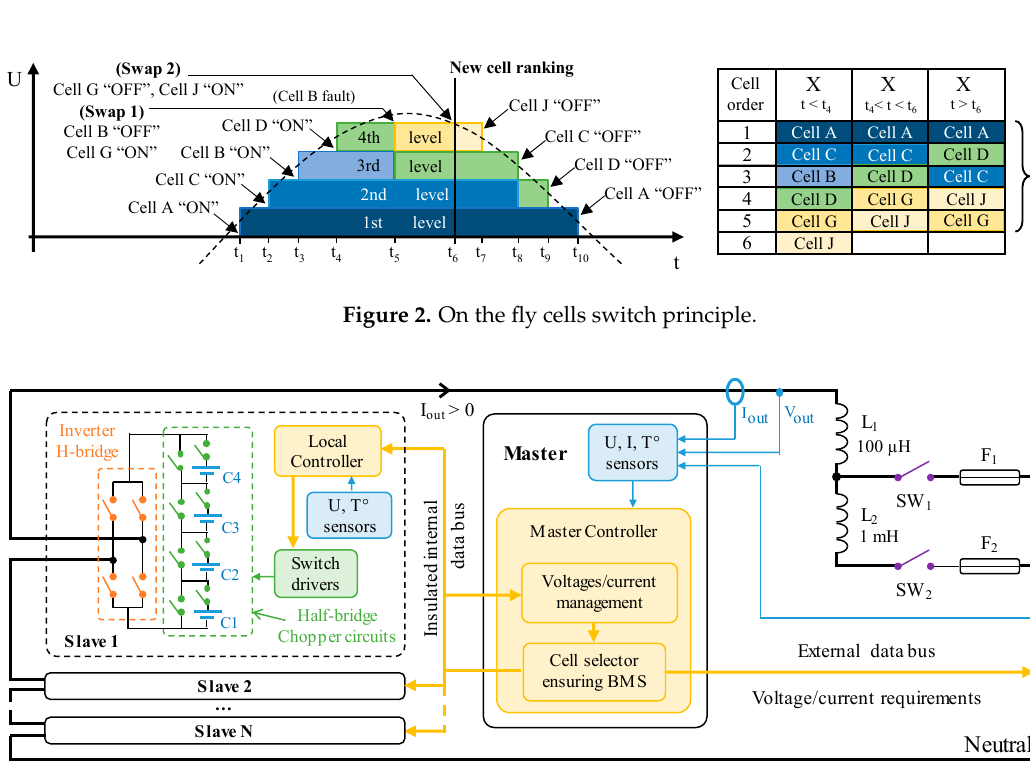
Figure 3. High frequency SRB (HF SRB) hardware architecture.